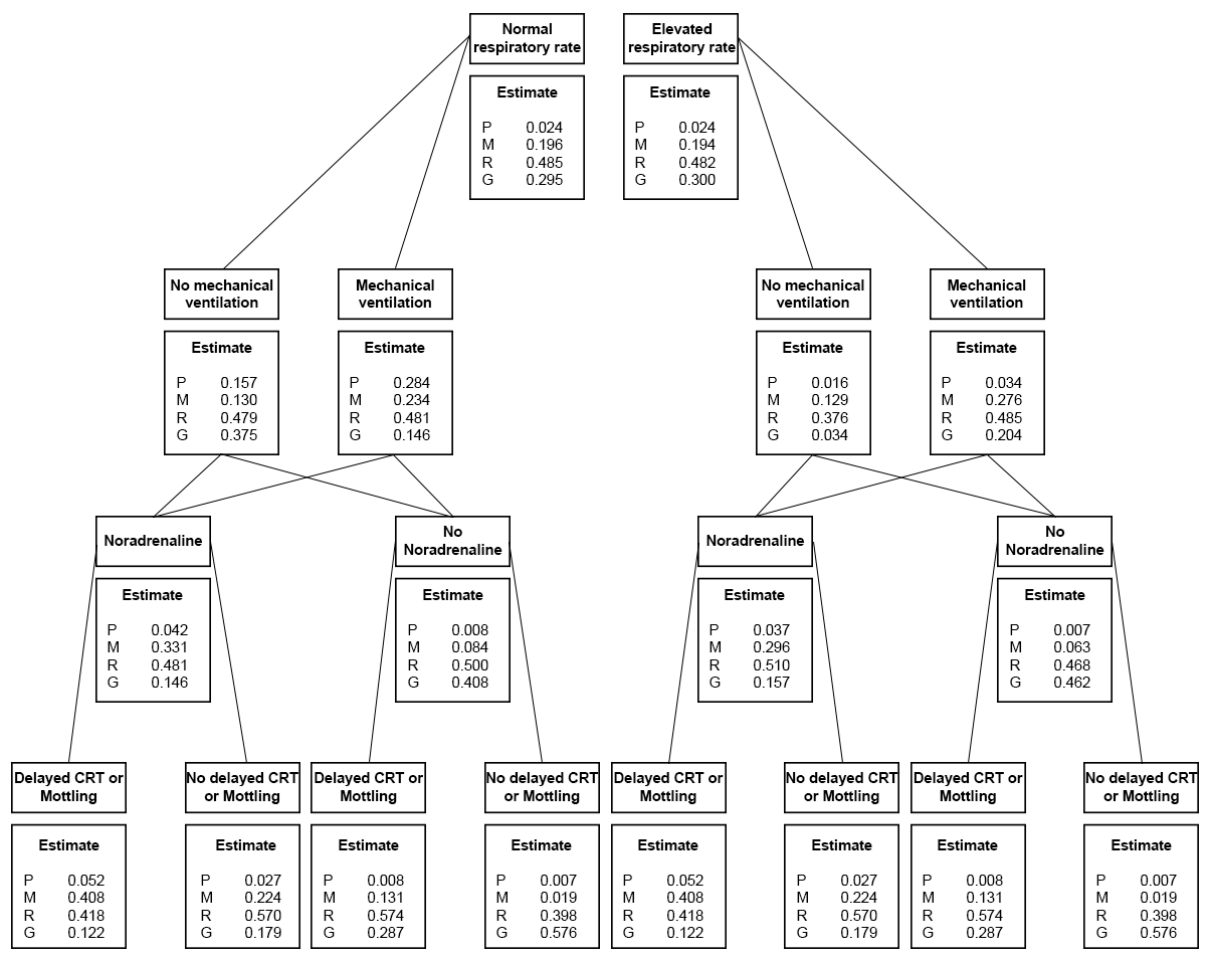
Figure 2. Tree diagram showing the conditional probabilities queries for estimate associated with multiple scenarios during clinical examination. At each step, only the variables above the split are known and as more information becomes available, the conditional probabilities change. P=Poor; M=Moderate; R=Reasonable; G=Good; CRT: capillary refill time.